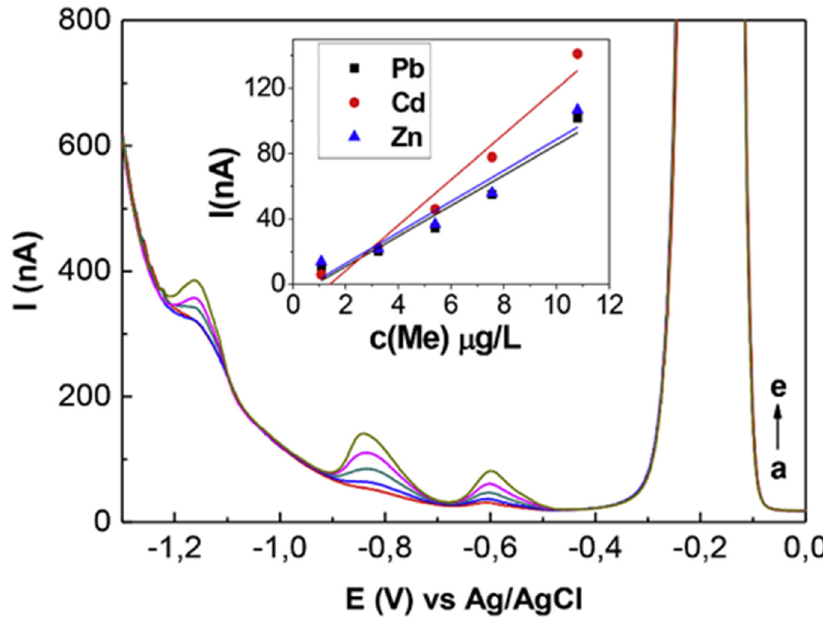
Figure 10. Square wave voltammograms for different additions of heavy metals with related calibration lines (electrode: CH 4 /H 2 = 1%, C B-C = 15,000 ppm, c (Bi) = 10 µg/L, a) c (Me) = 1 µg/L, b) c (Me) = 3 µg/L, c) c (Me) = 5 µg/L, d) c (Me) = 7 µg/L, e) c (Me) = 10 µg/L) (reproduced with the permission of [97]).